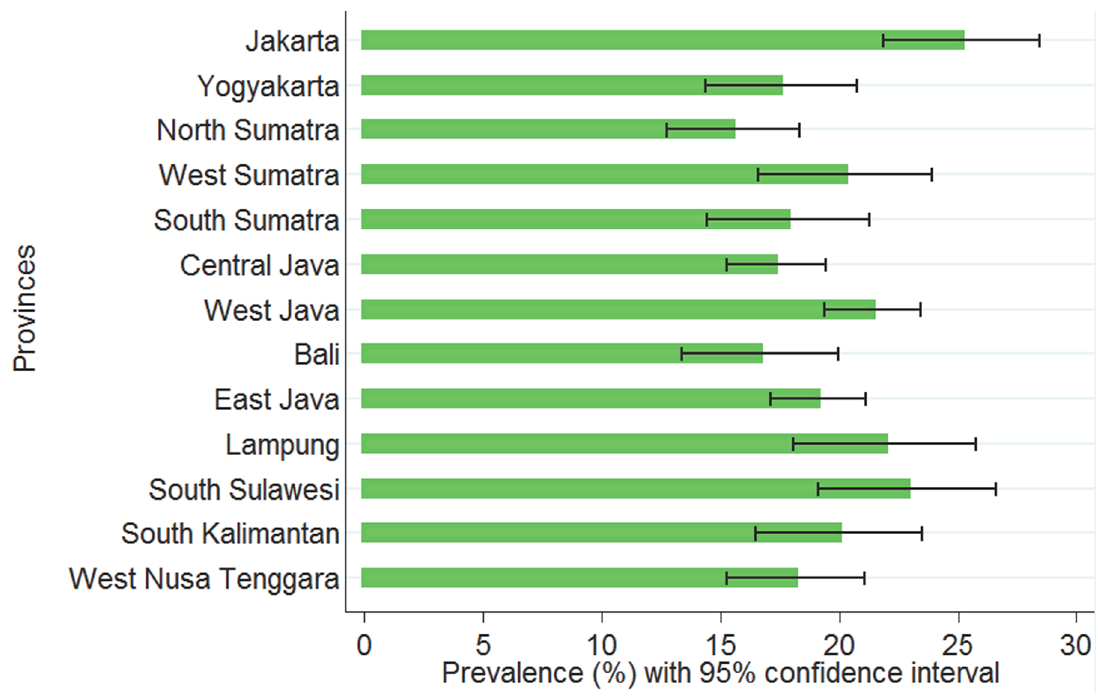
Figure 2. Prevalence of dual burden of malnutrition by province, sorted based on their Human Development Index (Jakarta and West Nusa Tenggara were the provinces with the highest and lowest HDI, respectively.